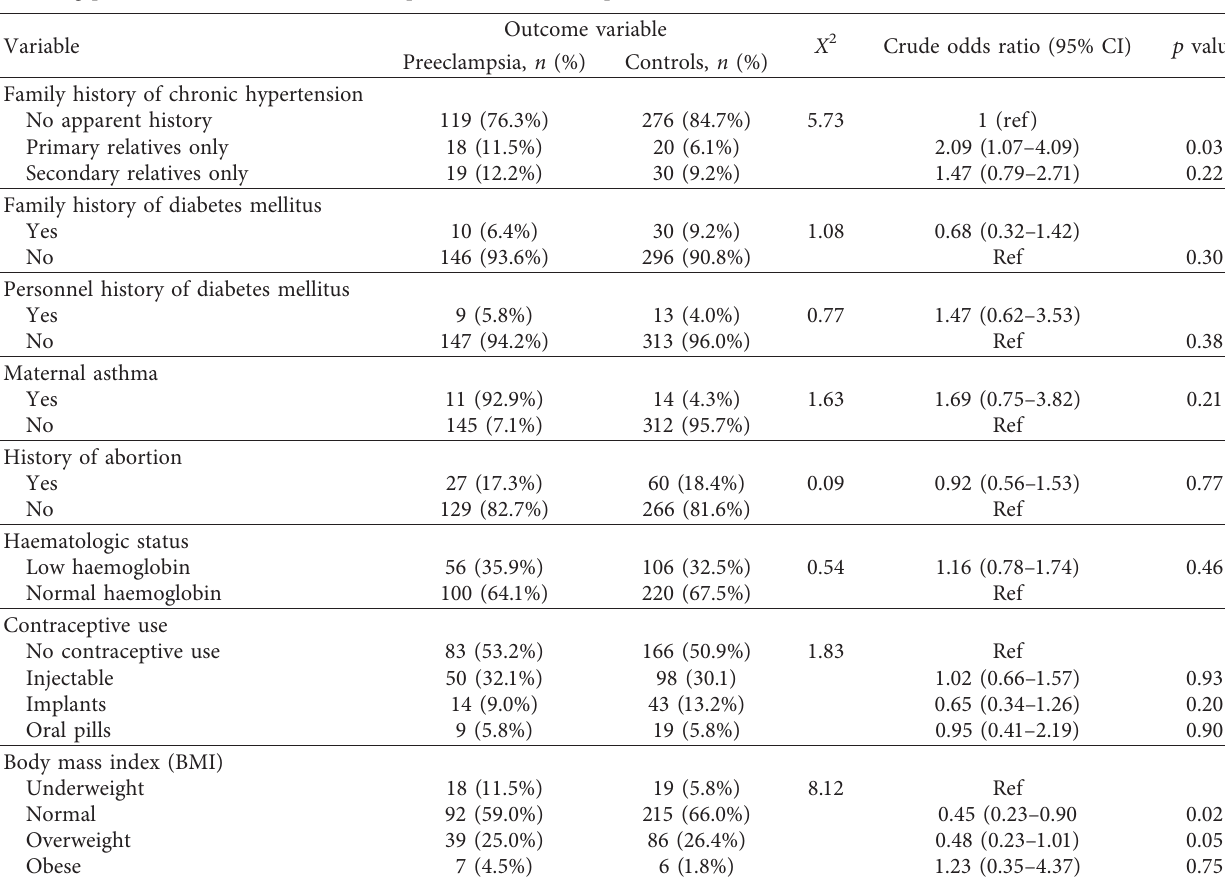
Table 2: Individual and family-related factors of women enrolled for a case-control study conducted among singleton pregnant women attending perinatal care in Omo district hospitals, southern Ethiopia.